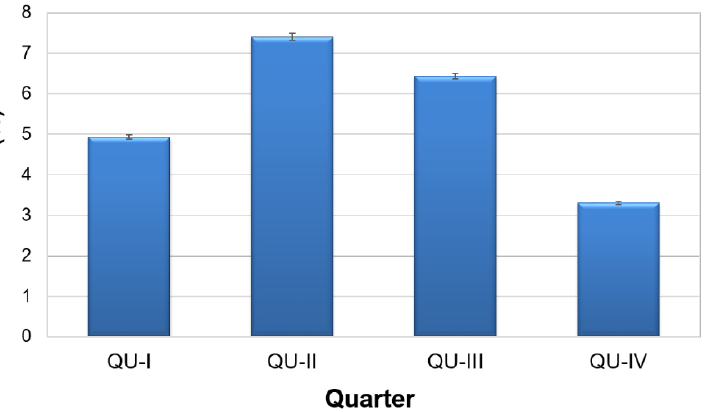
Figure 7. Biochemical Methane Potential Correction Coefficient (BMPCC) for individual quarters.